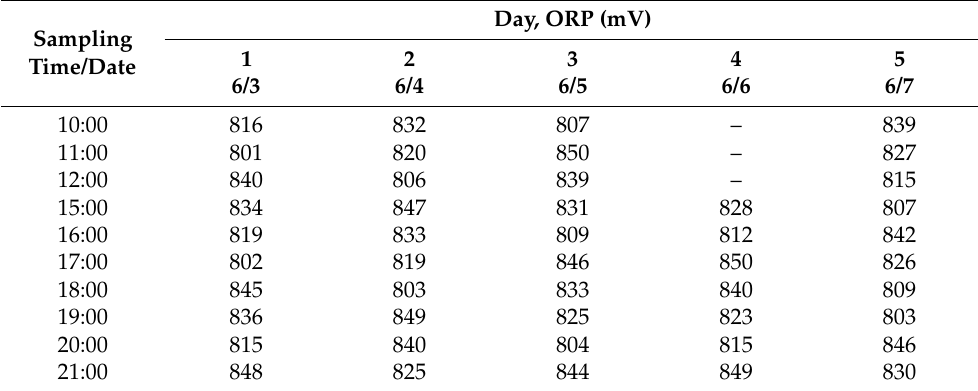
Table 3. Stabilization of water ORP in dental clinic.